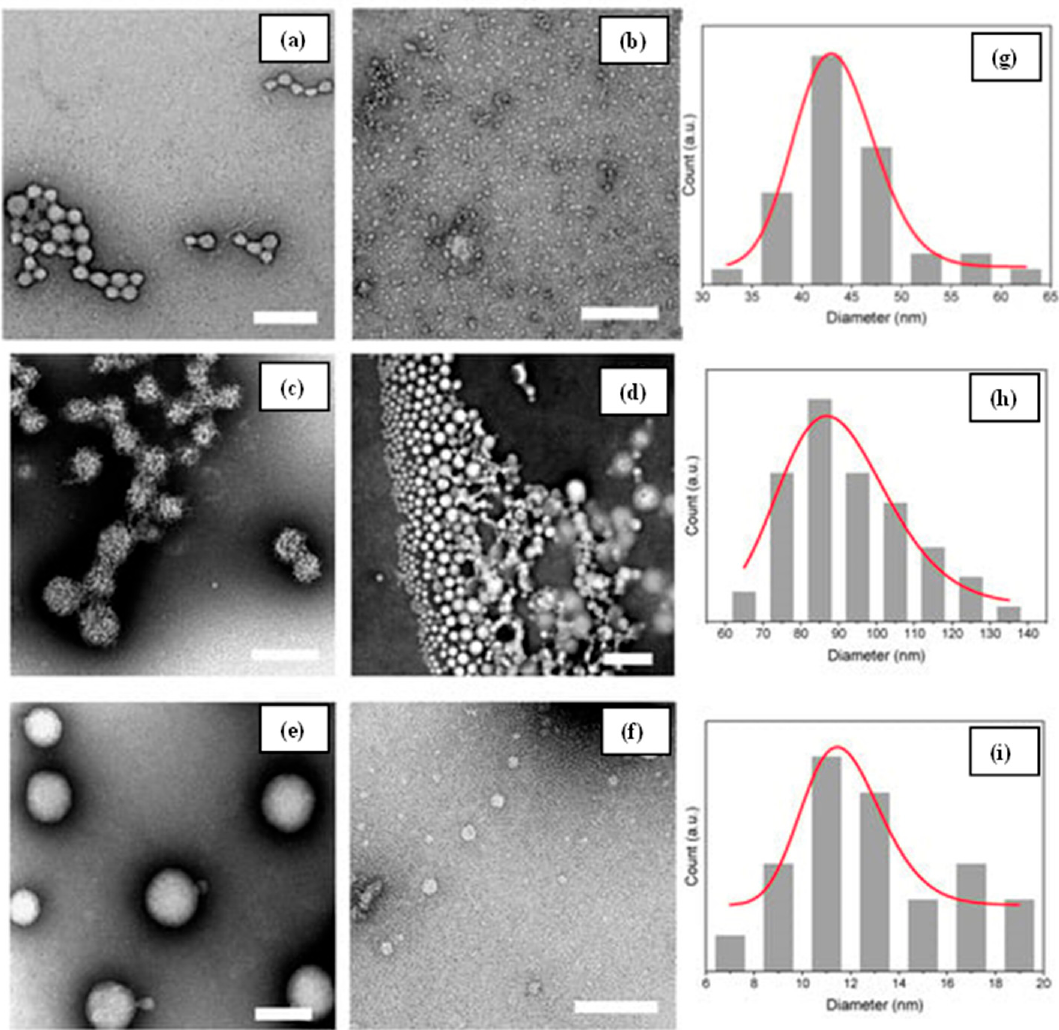
Figure 12. TEM images of prepared chitosan caseinate PEC nanoparticles ( a – f ), and the DLS particle size analyses results ( g – i ), adopted from open access resource [44].